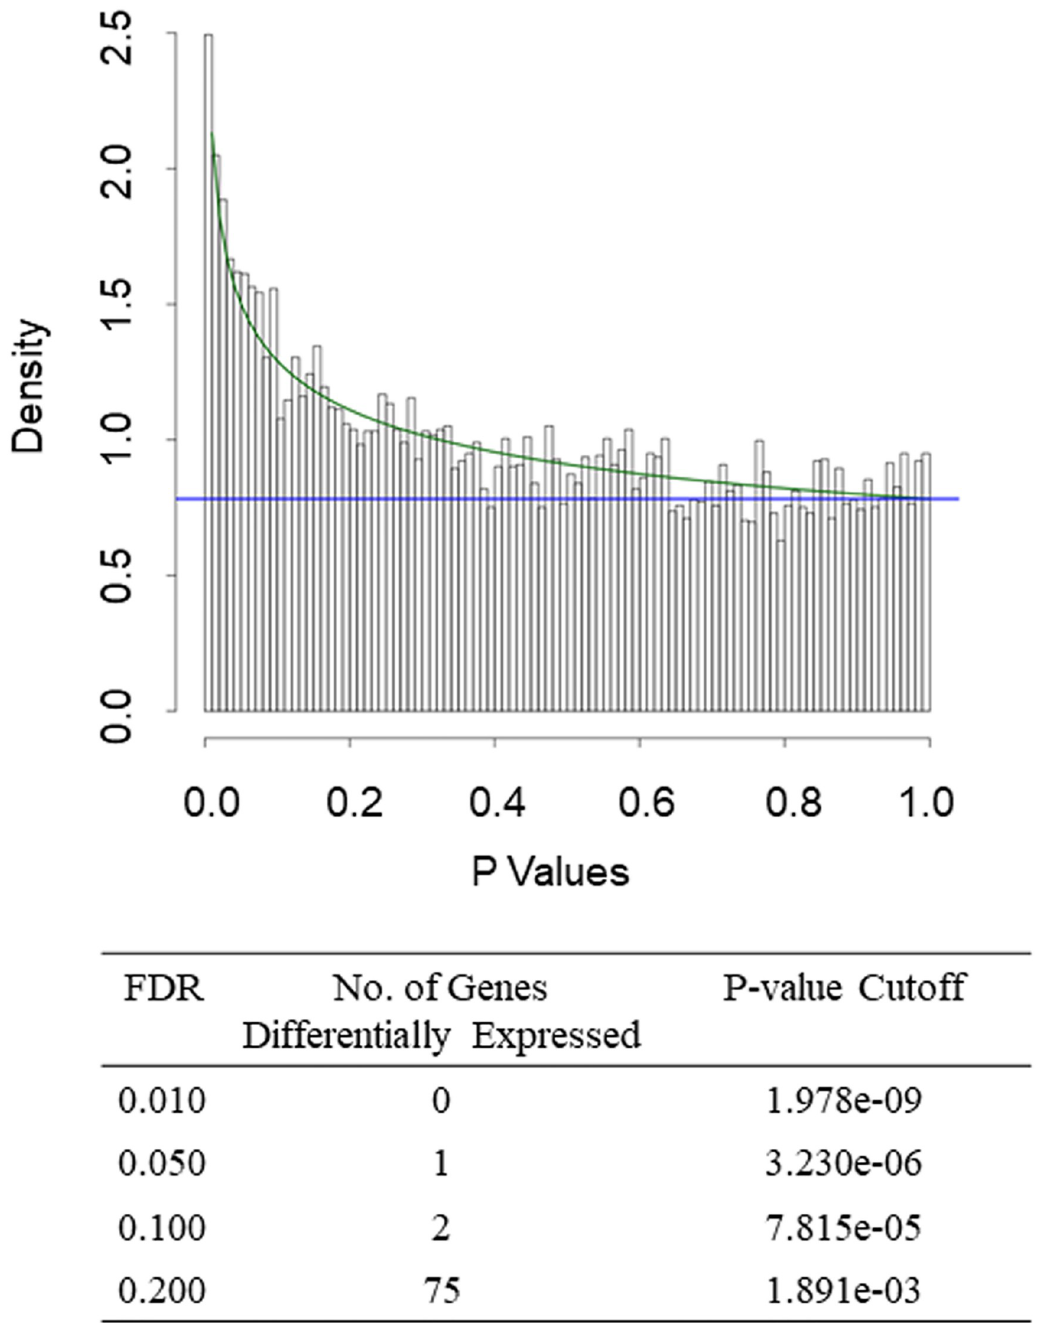
Fig 1. Gene expression in IBC versus non-IBC in 70 patients with non-MSL TNBC according to the Vanderbilt classification. Top, Histogram of P values from 2-sample t tests for gene expression in TN-IBC vs. TN-non-IBC. The overlaid curve is the fitted BUM model. Bottom, Counts of differentially expressed genes with various FDR